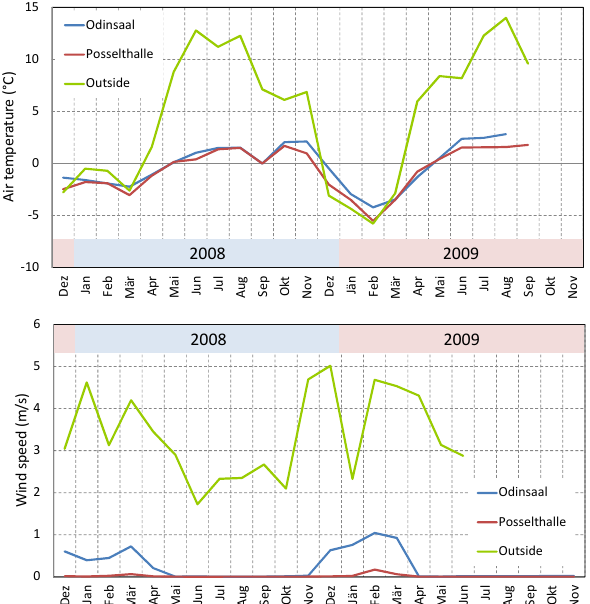
Fig. 6. Monthly averages of air temperature (top panel) and wind speed (bottom panel) at two AWS sites in cave Eisriesenwelt and one site outside the cave close to the entrance for the period De- cember 2007 to October